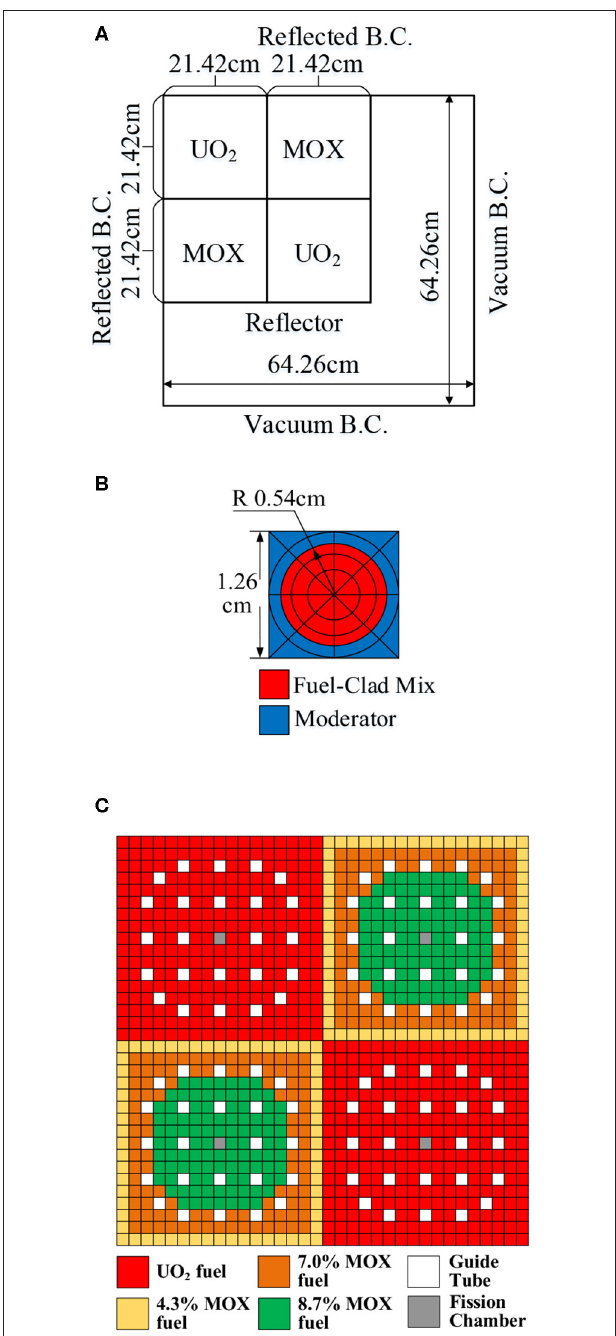
FIGURE 3 | (A) Core configuration for the 2-D C5G7 benchmark problem. (B) Fuel pin layout. (C) Benchmark fuel pin compositions.